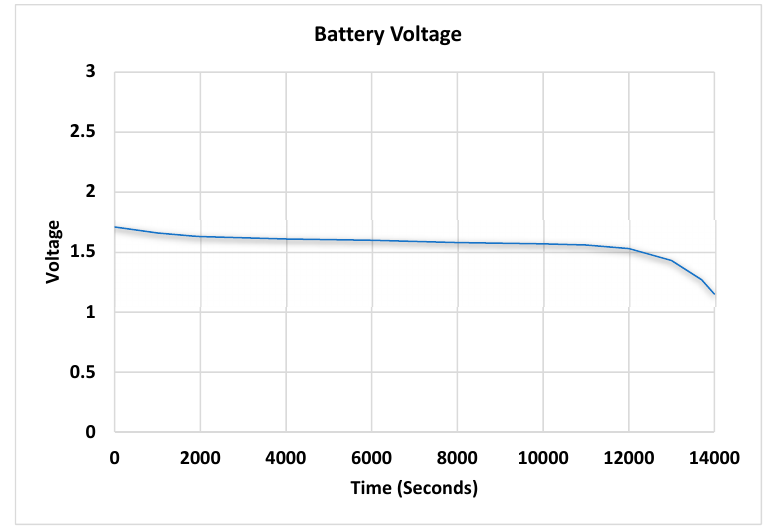
Figure 25. Discharging/Battery Voltage.